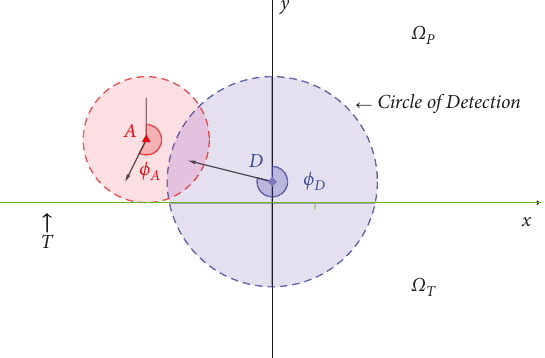
Figure 1: The reach-avoid game with a time limit and detection